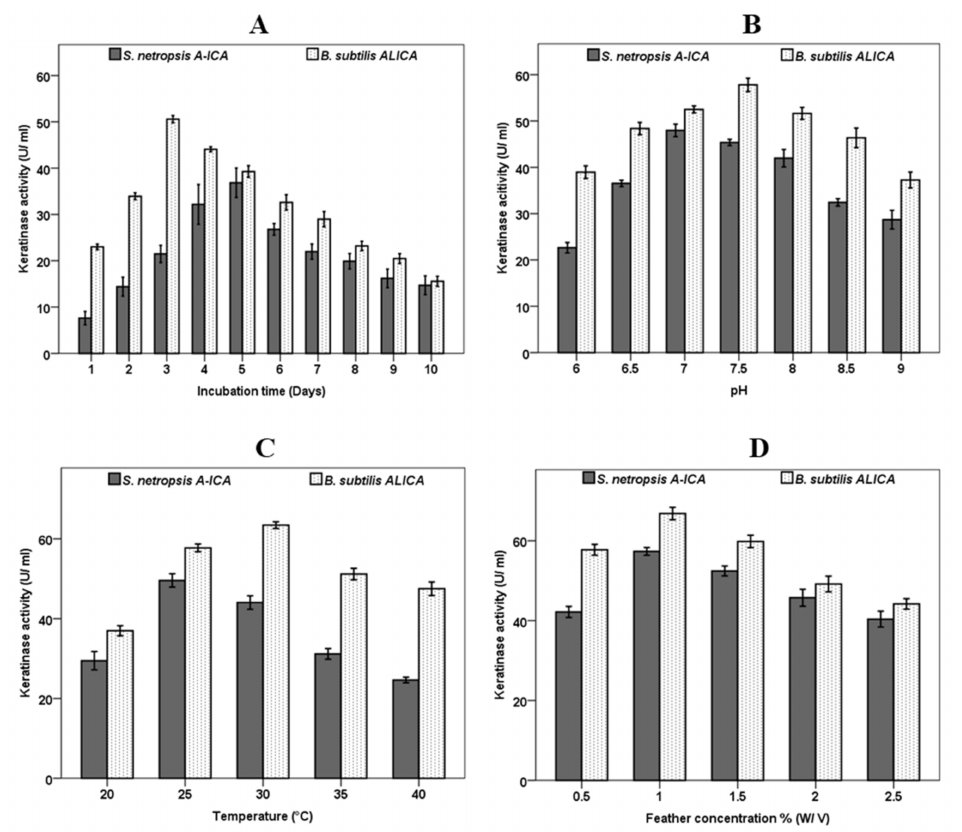
Figure 2. Effect of incubation time ( A ), pH ( B ), Temperature ( C ) and Feathers concentration ( D ) on Keratinase activity produced by S. netropsis A-ICA and B. subtilis